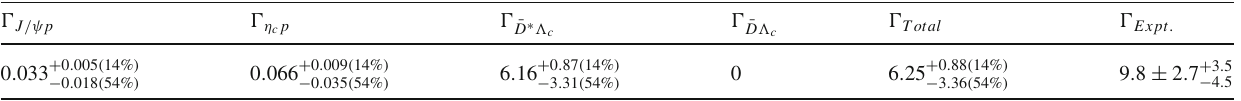
Table 3 The calculated partial decay widths (in units of MeV) compar- about + 7% and − 32% uncertainties for the calculated binding energy ing to the experimental measurement. The positive and negative devia- of P c ( 4312 ) in the extended chiral constituent quark tionsinthesecondlinefor (cid:6) J /ψ p , (cid:6) η , (cid:6) ¯ ,and (cid:6) Total arebasedon D ∗ (cid:3) c c p